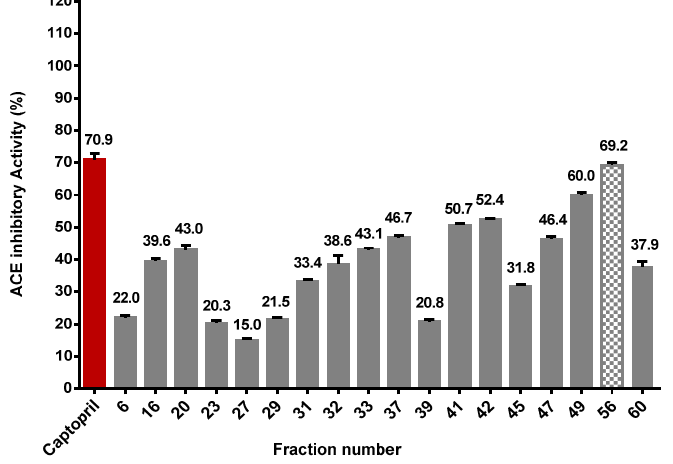
Figure 6. ACE inhibitory activity (%) of egg yolk protein fractions separated on a Sephadex G-25 column. The activity (%) of 10 mg/mL for each gel filtration fraction to inhibit ACE was measured by HPLC and is shown at the top of the bars. Captopril (0.5 mg/mL), shown in red, was used as a positive control. The shaded bar denotes fraction 56 with the highest ACE inhibitory activity. Data correspond to the means ± SD of three independent experiments. ANOVA was performed in Graphpad Prism version 6.0. followed by Dunnett’s multiple comparisons test.